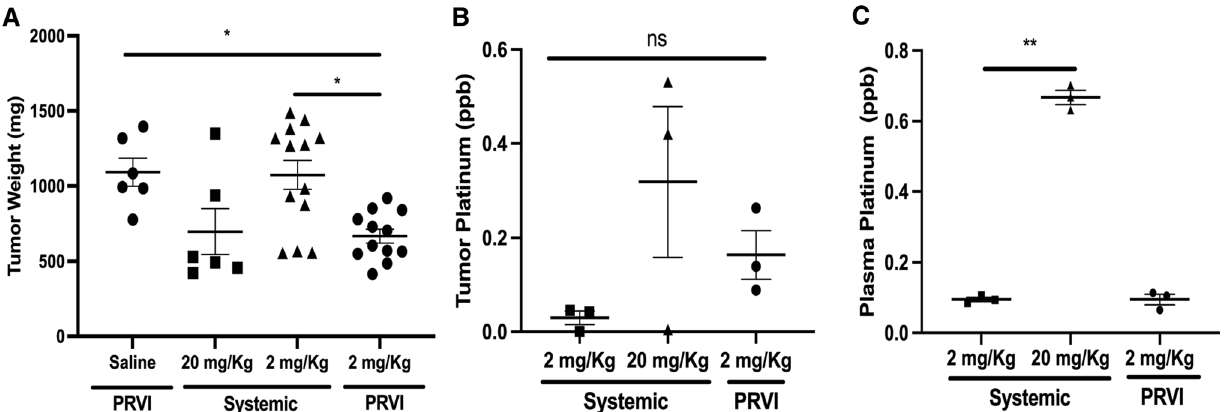
Fig. 2 Pancreatic retrograde portal venous infusion (PRVI) of oxaliplatin can minimize the neuropathic effects of systemic oxaliplatin deliv- ery by reducing the dose required for effective tumor control. A Tumor burden in the orthotopic PDAC mice 7 days post treatment shown as mean±SEM of tumor weights among the survivors of n=15 mice in each group. B Platinum concentration in the tumor and the circulating platinum levels in the plasma C were measured 3 h post infusion using inductively coupled plasma mass spectrometry (ICP−MS) and repre- sented as mean±SEM parts per billion in 3 mice per